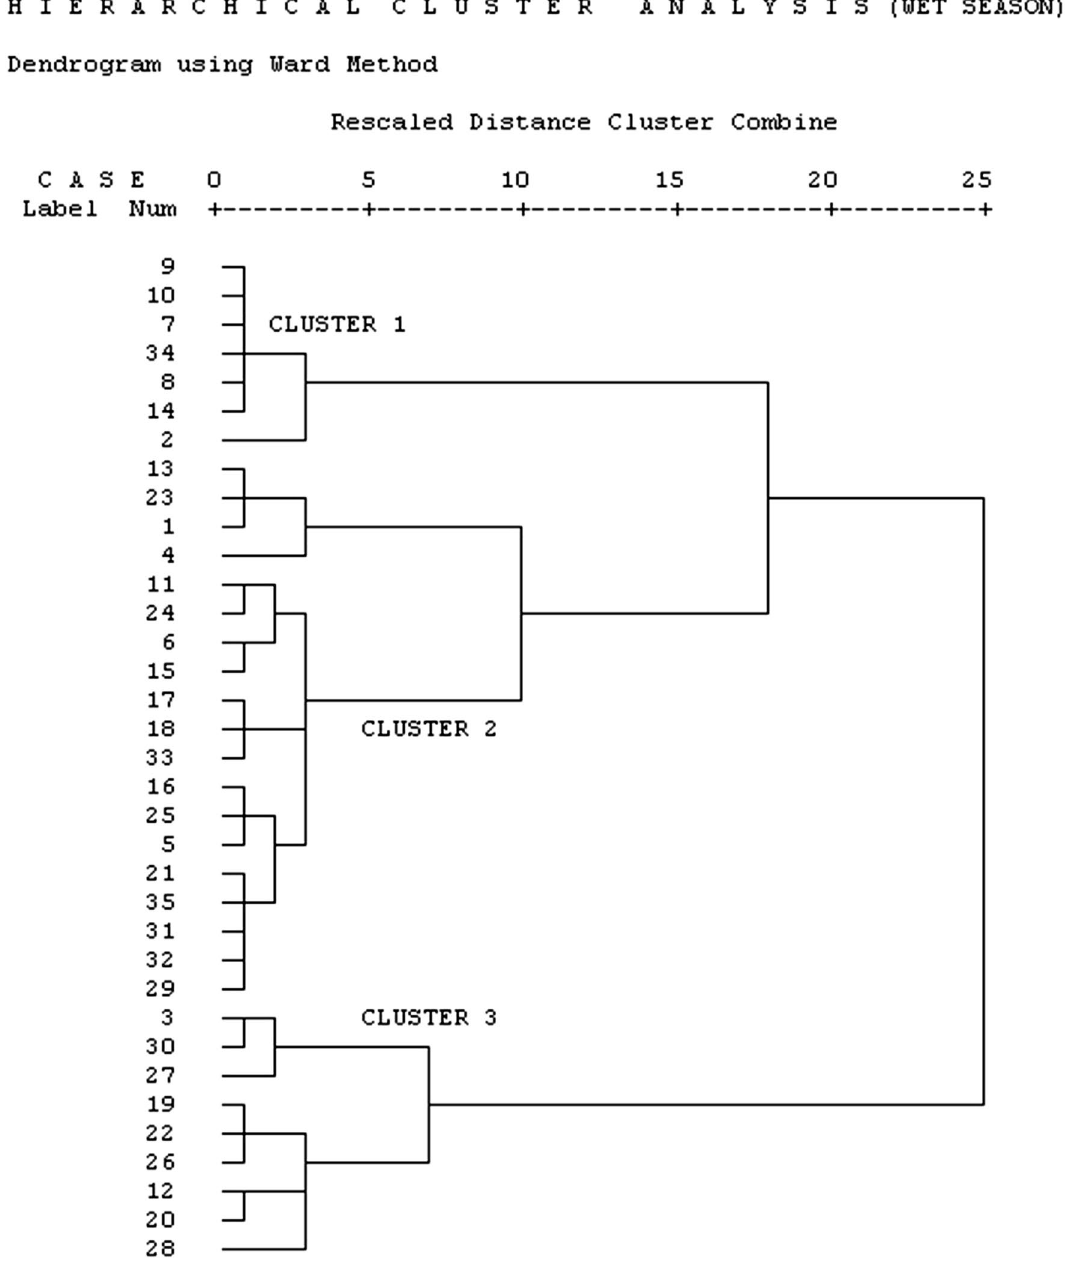
Fig. 9 Dendrogram of hierarchical cluster analysis of the SW sources in the wet